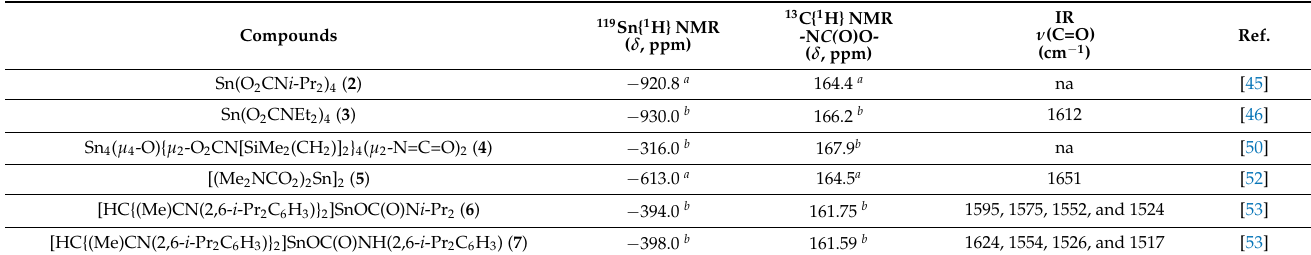
Table 2. Selection of spectroscopic data (NMR and IR) assigned to carbamates of tin complexes.